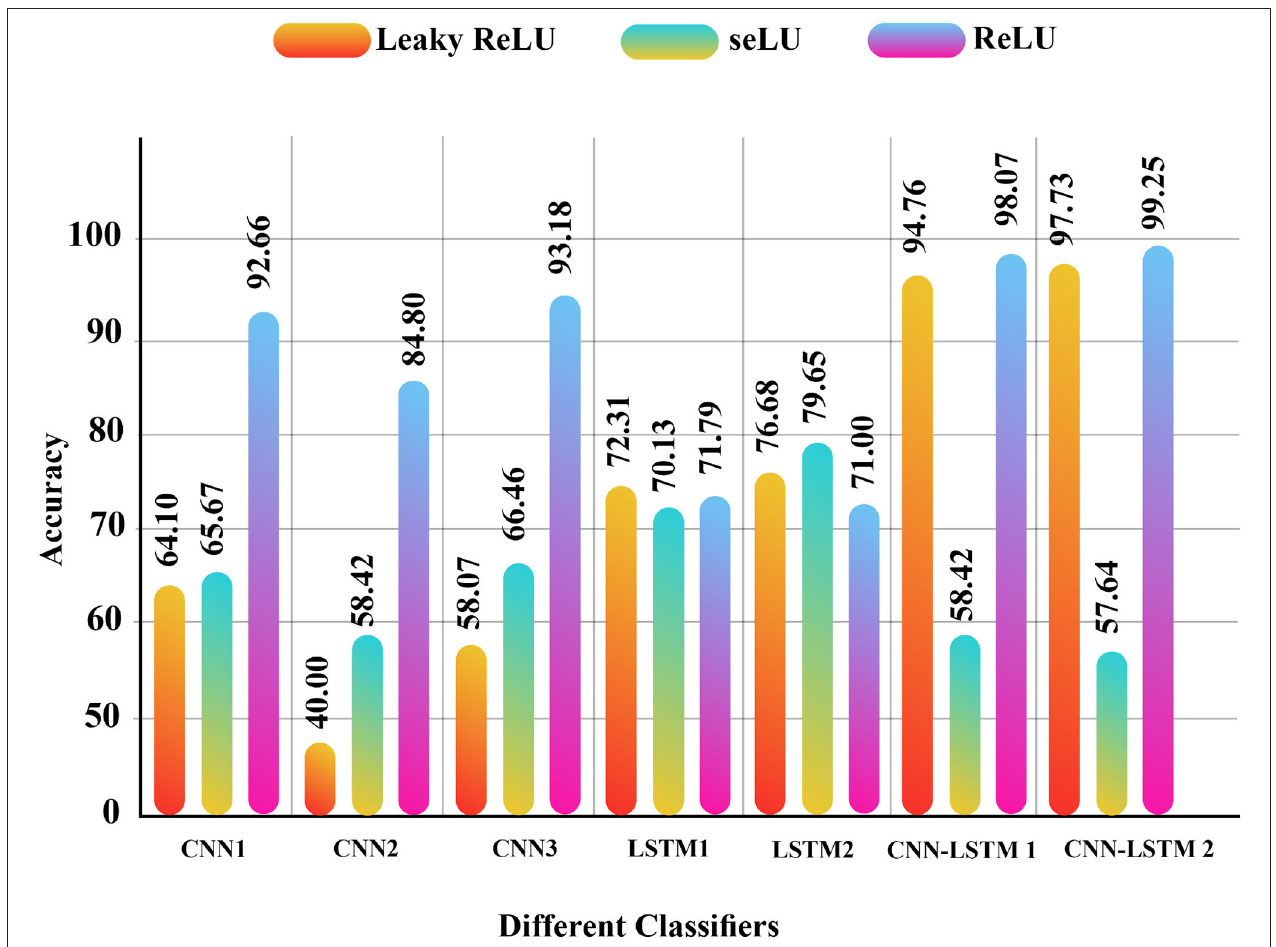
FIGURE 10 | Results for different proposed DL methods with different activation functions and z -score with L2 normalization. DL, deep